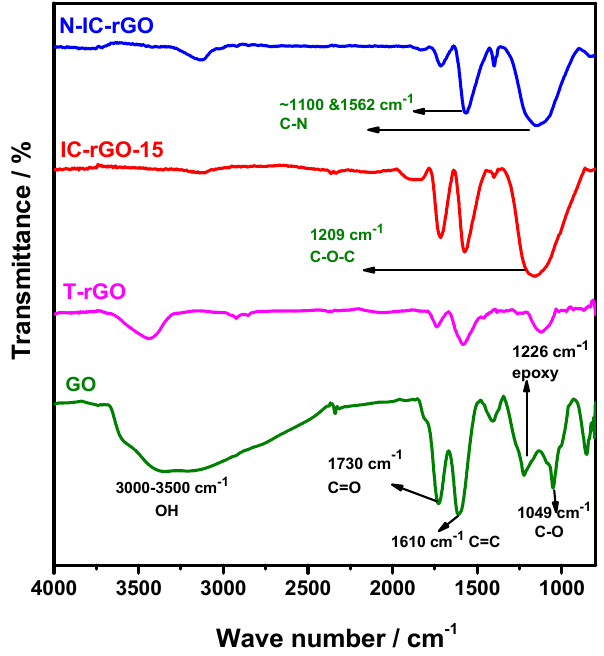
Figure 3. Fourier transform infrared (FTIR) spectra of N-IC-rGO, IC-rGO, T-rGO (thermally reduced graphene oxide), and GO (adapted from ref. [78], with permission from Royal Society of Chemistry, 2017).